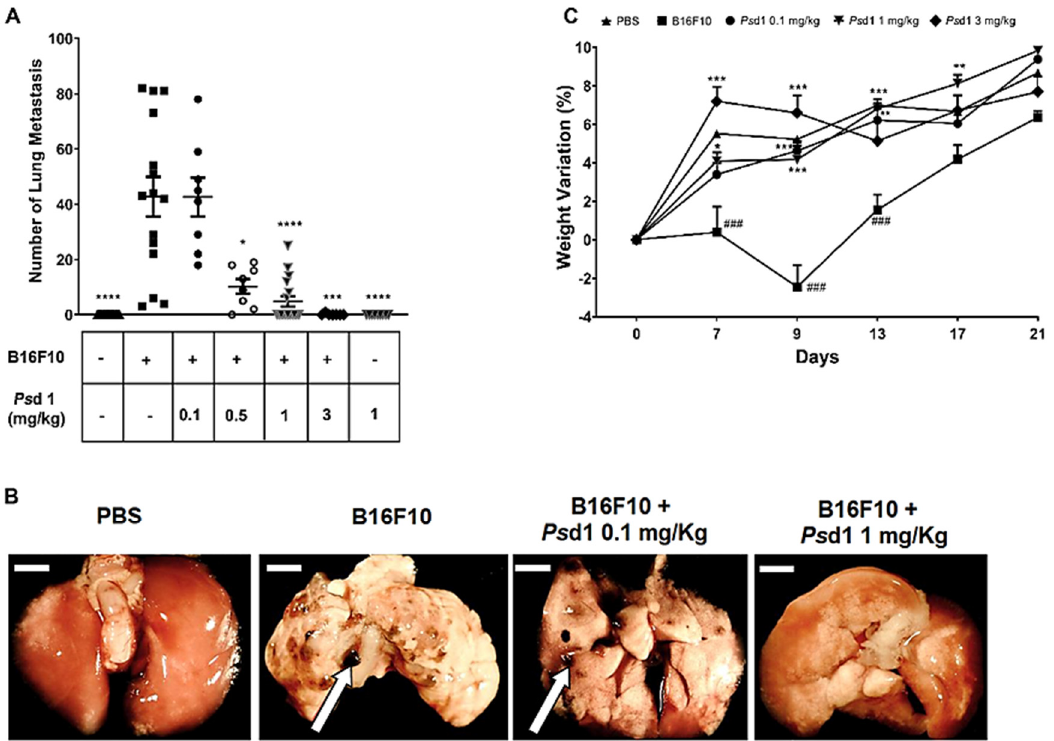
Figure 6. Protective e ff ects of Ps d1 on a model of experimental lung metastasis in vivo. B16F10 mouse melanoma tumors were established by intravenous injection of 2.5 × 10 5 B16F10 cells into C57BL / 6 mice. ( A ) After 21 days, mice from each experimental group were sacrificed, and the number of visible lung metastatic nodules was quantified. Treatment of the animals inoculated with melanoma cells plus Ps d1 caused a dose-dependent reduction in the number of lung metastases. Black lines represent the mean ± SEM of two independent experiments analyzed by one-way ANOVA and Bonferroni’s multiple comparison test. **** p < 0.0001 B16F10 vs. phosphate bu ff er solution (PBS); **** p < 0.0001 B16F10 vs. Ps d1 1 mg / kg; **** p < 0.0001 B16F10 vs. just Ps d1 1 mg / kg (without B16F10 cells); *** p < 0.001 B16F10 vs. Ps d1 3 mg / kg; * p < 0.05 B16F10 vs. Ps d1 0.5 mg / kg. ( B ) Representative images of lung metastatic nodules from animals that received just PBS or B16F10 cells alone or together with 0.1 mg / kg or 1 mg / kg Ps d1. Bar = 2 mm. ( C ) Animal weights were acquired every two days. Weight variation was calculated as (weight on that day (weight of the first day × 100 − 100)). Only the days with higher weight di ff erences between animals injected with only B16F10 cells and those that received cells plus Ps d1 or PBS alone are represented. All of the values represent the mean ± SEM of two independent experiments analyzed by two-way ANOVA. *** p < 0.001 B16F10 vs. PBS at 7, 9 and 13 weeks; *** p < 0.001 B16F10 vs. Ps d1 0.1 mg / kg at 9 weeks; ** p < 0.01 B16F10 vs. Ps d1 0.1 mg / kg at 13 weeks; *** p < 0.001 B16F10 vs. Ps d1 1 mg / kg at 9 and 13 weeks; ** p < 0.01 B16F10 vs. Ps d1 1 mg / kg at 17 weeks; * p < 0.05 B16F10 vs. Ps d1 1 mg / kg at 7 weeks; *** p < 0.001 B16F10 vs. Ps d1 3 mg / kg at 7 and 9